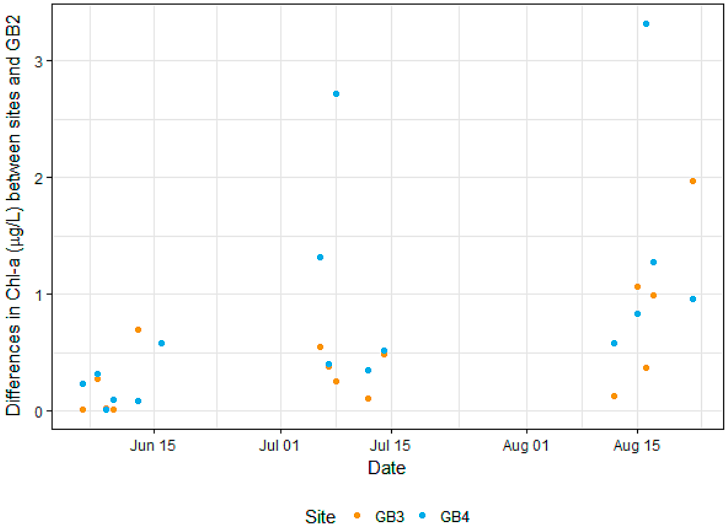
Figure 7. Variability between Sites (Approximately 1000 m distances, or MODIS Scale) in the Great Salt Lake (GB Sites).